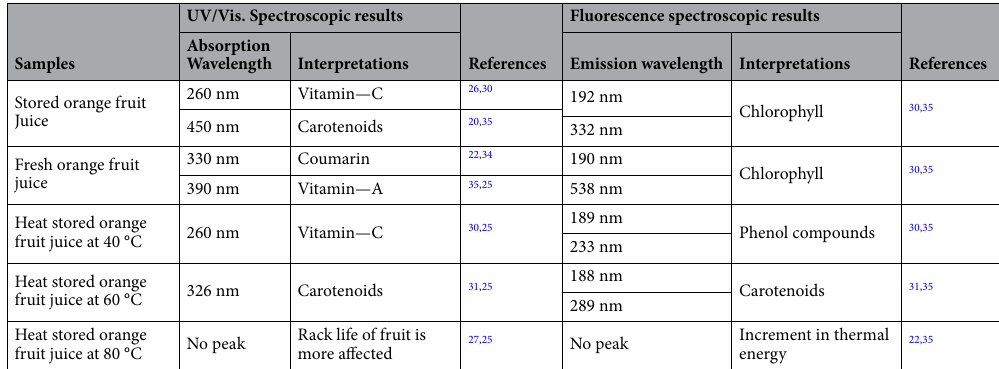
UV/Vis. Spectroscopic results